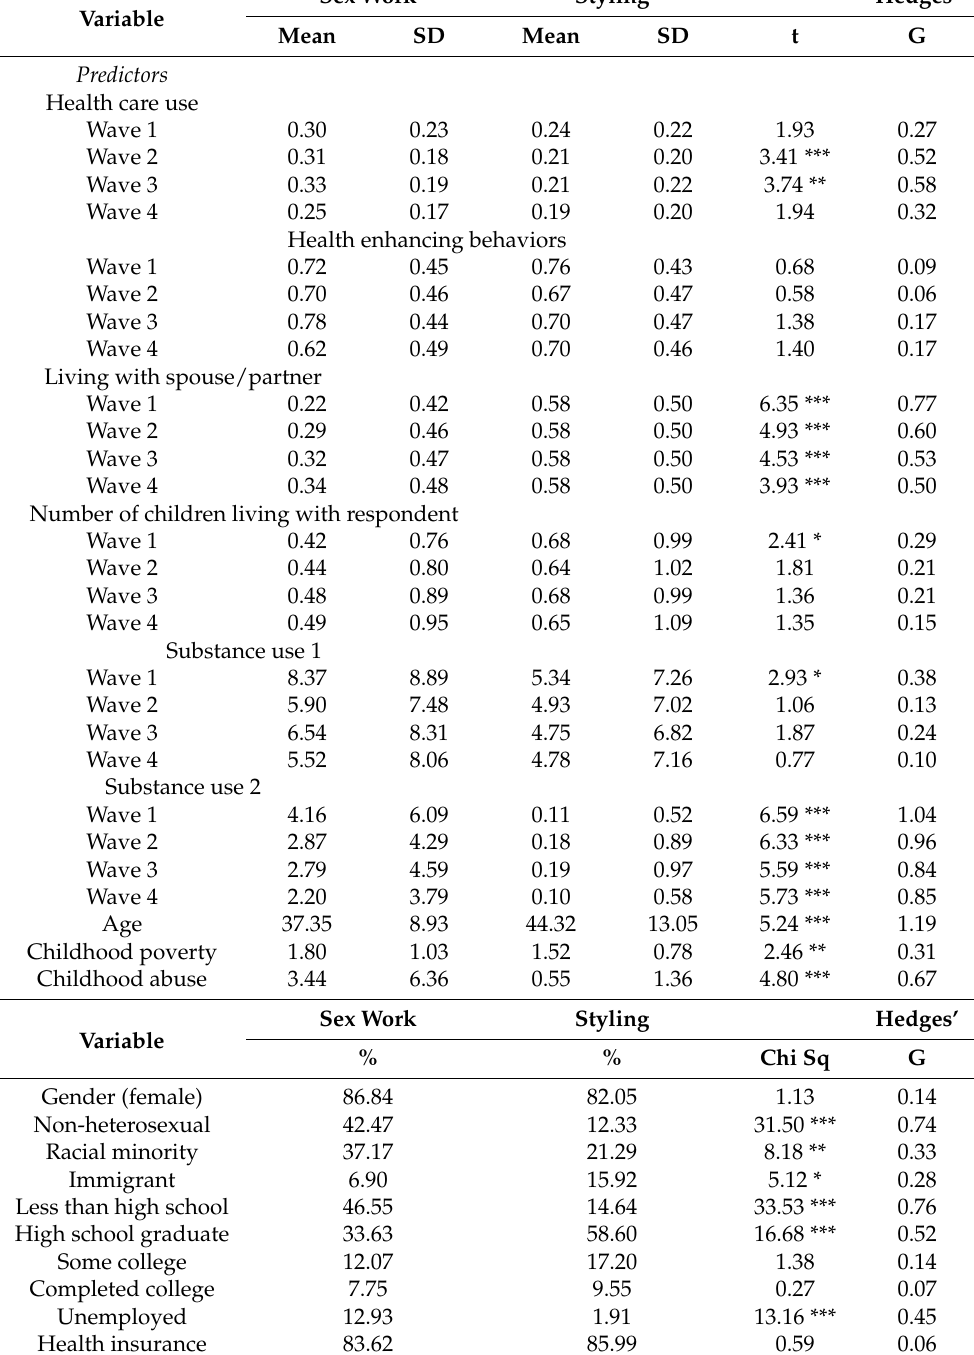
Table 1. Descriptive Statistics, Test of Difference, and Effect Size, Control Variables